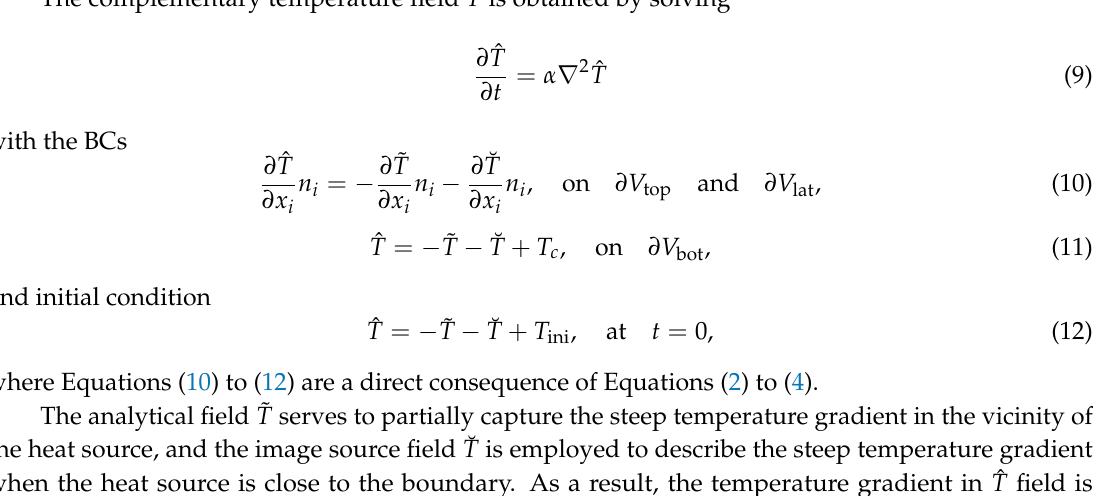
Figure 2. The strategy of adding image sources. The original heat source is represented by the red source and the image source is represented by the blue source. Image source J the original source with respect to boundary ∂ B ( 1 ) , and image source J original source with respect to boundary ∂ B ( 2 ) . Image source J ( 1 ) J with respect to boundary ∂ B ( 2 ) . The subscript of J 1 superscript represents the boundary by which the image source is mirrored. For the parallel boundaries ∂ B ( 1 ) and ∂ B ( 2 ) , an infinite number of image sources need to be